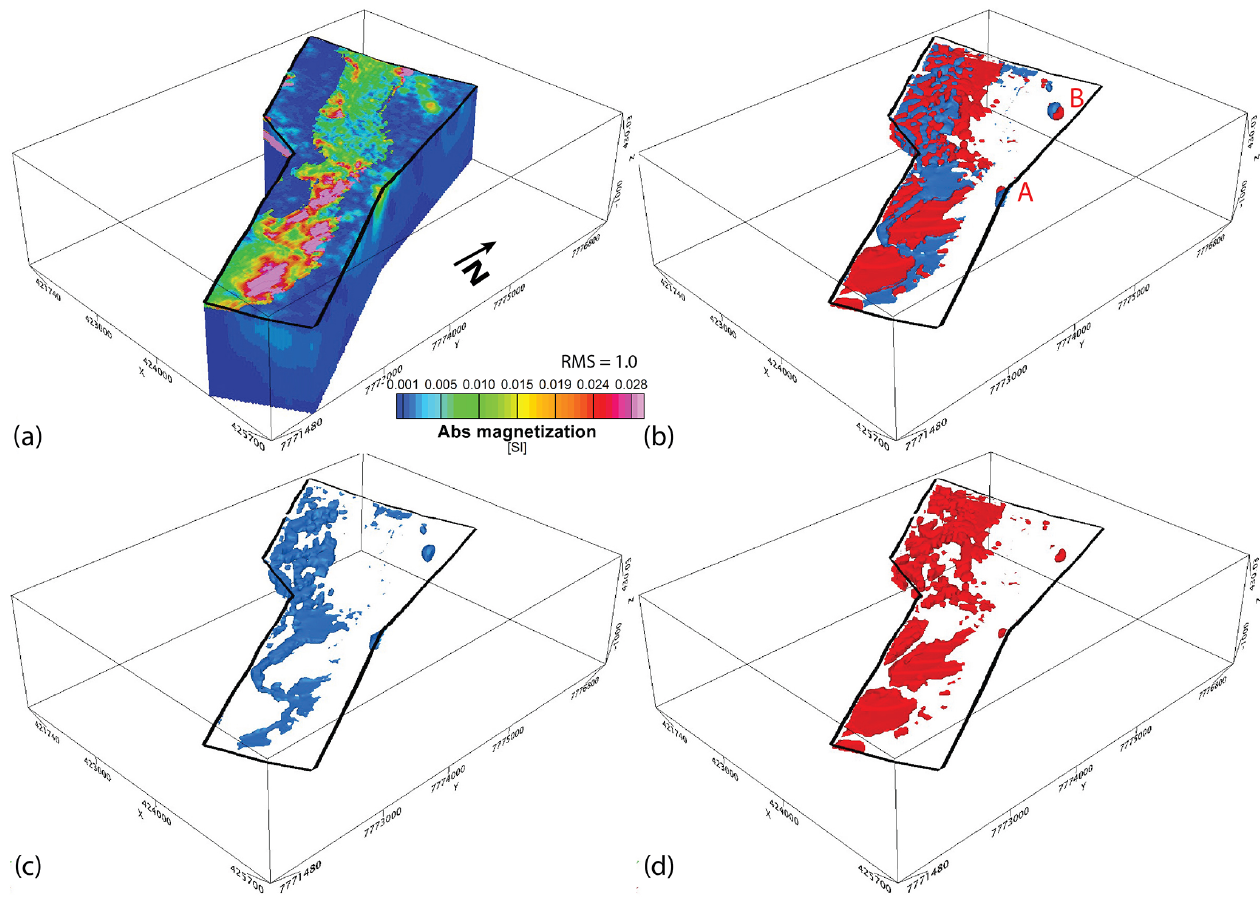
Figure 6. Results from the MVI test, where cells associated with sediment units were constrained towards a non-magnetic reference model, while cells associated with magmatic rocks remained unconstrained. Only the shallow central part of the model down to a depth of 1000m is shown which was covered by data from the fixed wing survey (black polygon). (a) The final magnetization distribution is presented as absolute values of the magnetization vectors. (b) Only cells with absolute magnetization values > 0 . 01SI are shown as iso-surfaces. Blue and red colours are associated with locations where the z component of the magnetization points out of the ground ( z component is positive) and into the ground (negative z component), respectively. These two contributions are presented separately in (c) and (d)